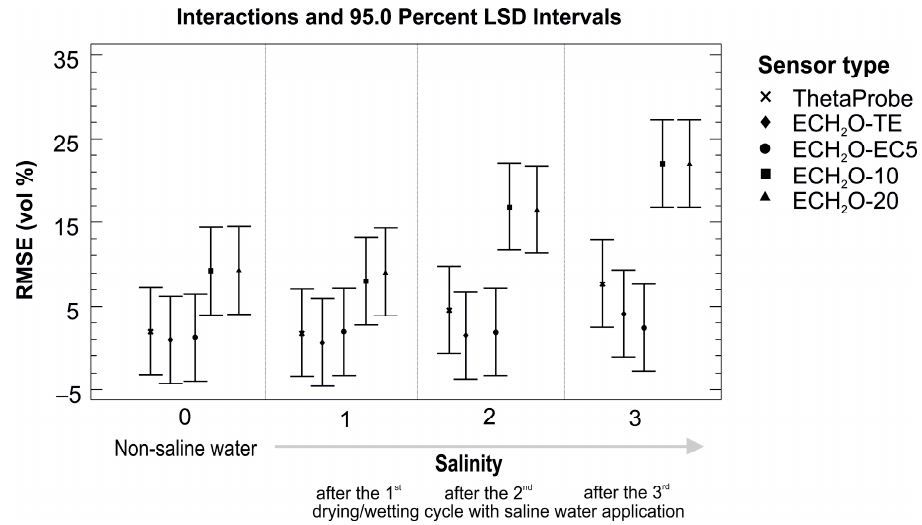
Figure 7. Sensor performance comparison based on RMSE (vol %) values for saline conditions.